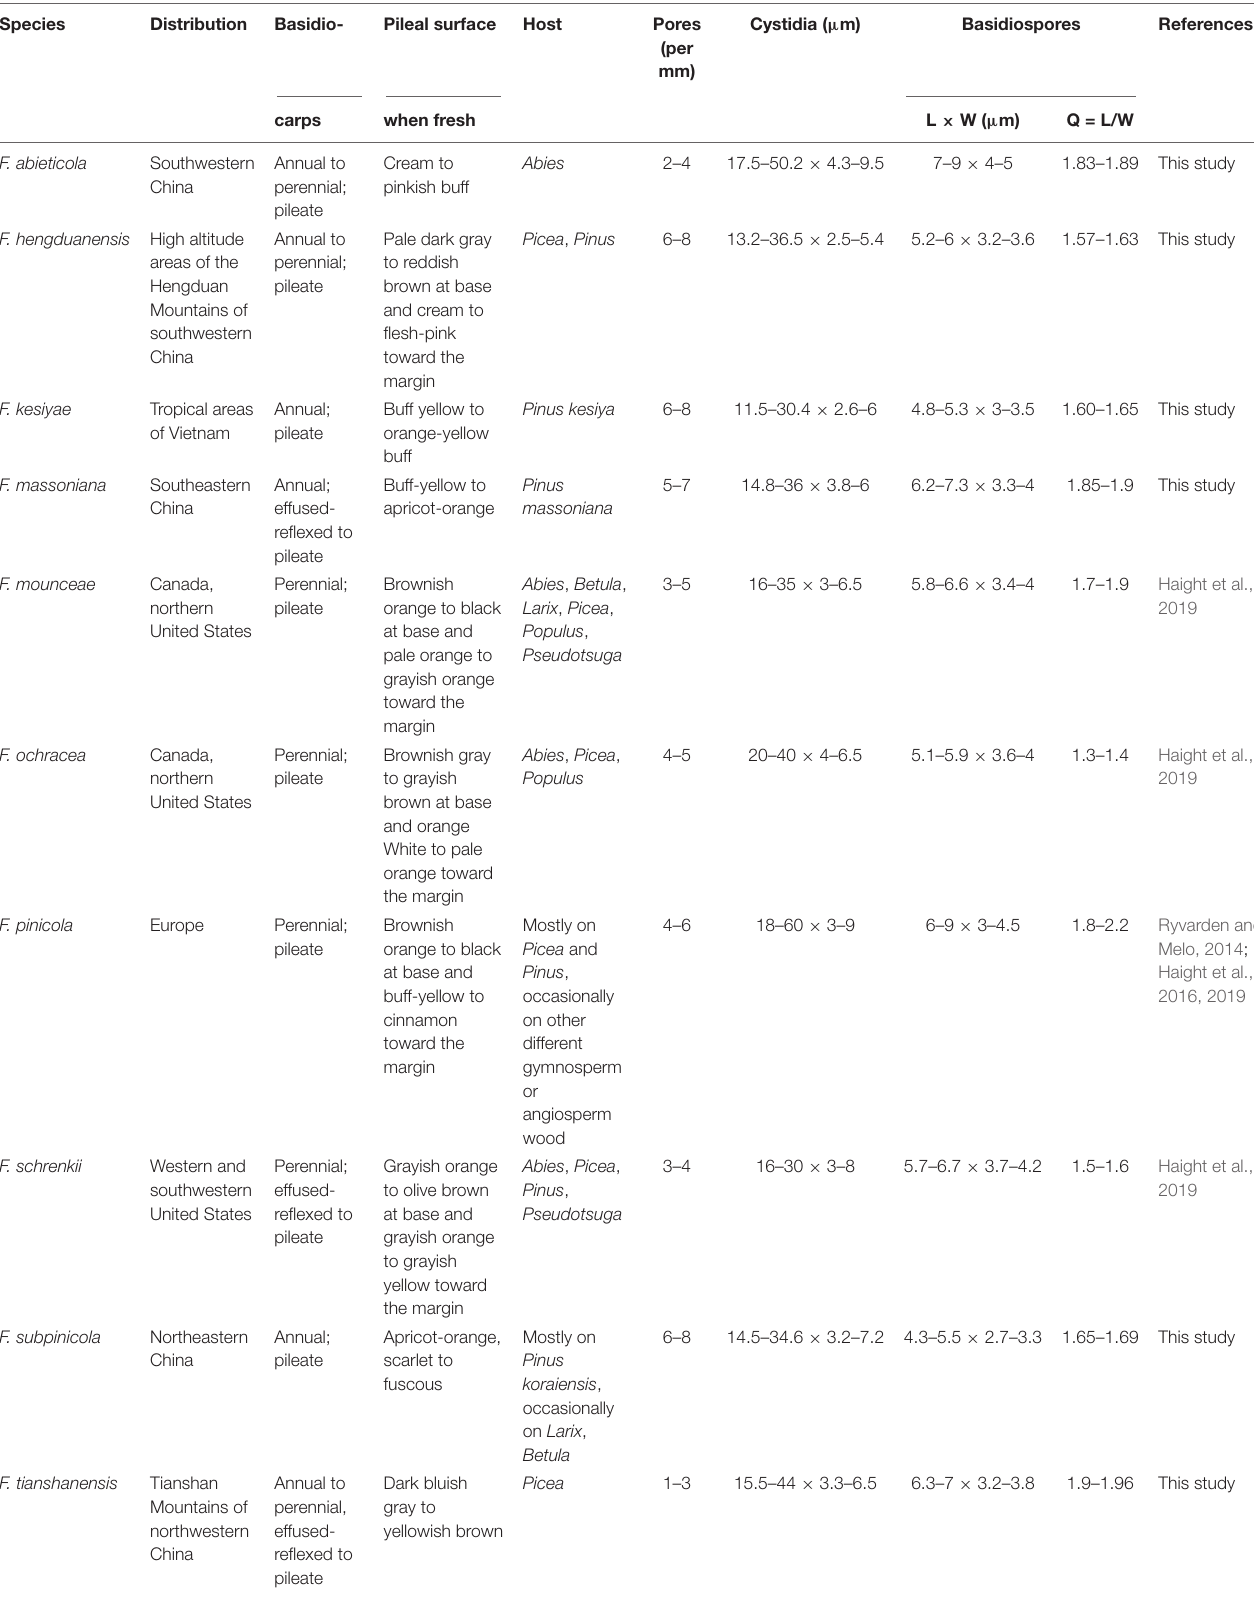
TABLE 2 | A comparison of species in the Fomitopsis pinicola complex.